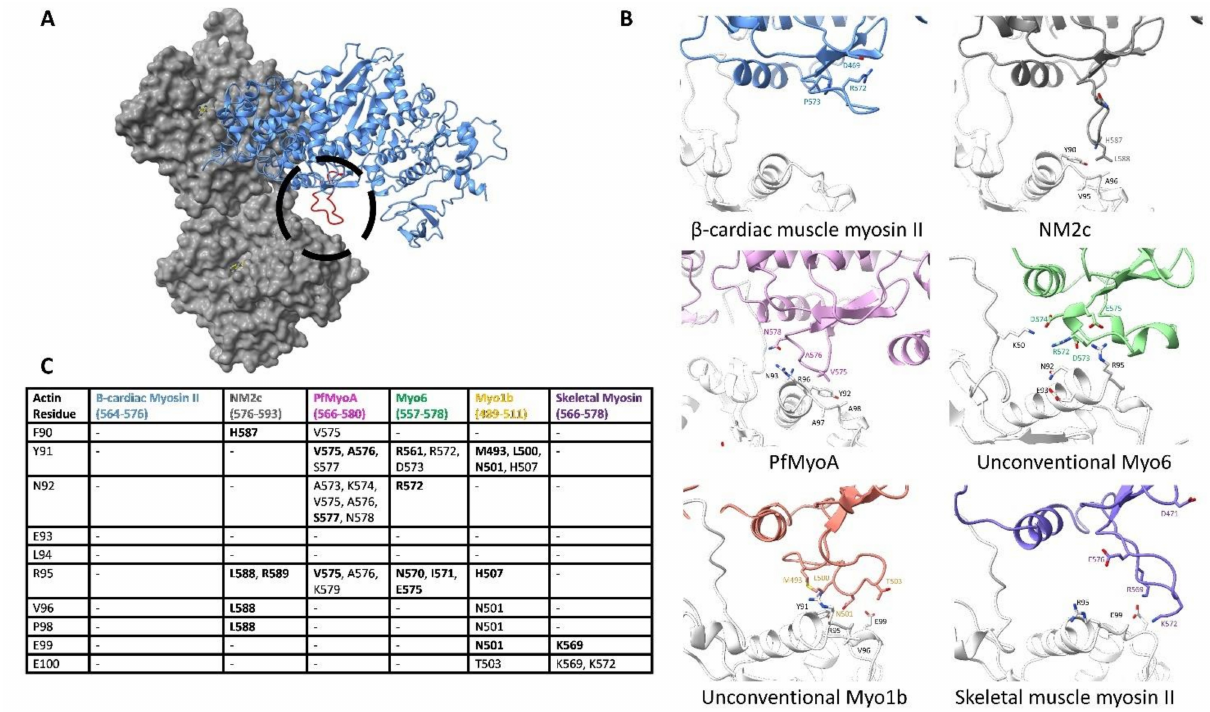
Figure 5. Actin subdomain 1 contacts myosin loop 3. ( A ). The overall positioning of the actin surface relative to loop 3. The motor domain is in blue while loop 3 is colored in red and circled; actin is in gray. ( B ). The residue-level binding interface between actin subdomain 1 and myosin loop 3 from the myosin structures is indicated in Supplementary Item Table S2. Actin backbone and residues are colored white, while myosin residues are colored by isoform. Noted residues involved in binding are shown and labeled. This figure makes it clear that loop 3 is variable and makes isoform-specific contacts with the actin subdomain 1. The cardiac β -myosin II makes no contact with the actin surface, while unconventional myosin 6 and 1b make a series of interactions. ( C ). Residue-to-residue contacts determined for the cryo-EM structures indicated in Supplementary Item Table S2. All residues on myosin that come within 5 Å of the indicated actin residue are listed with residues coming within 4 Å appearing in bold. The actin sequence is based on the Chicken ACTA1 numbering (UniProt: P68139). The myosin II isoforms make significantly fewer interactions compared with other